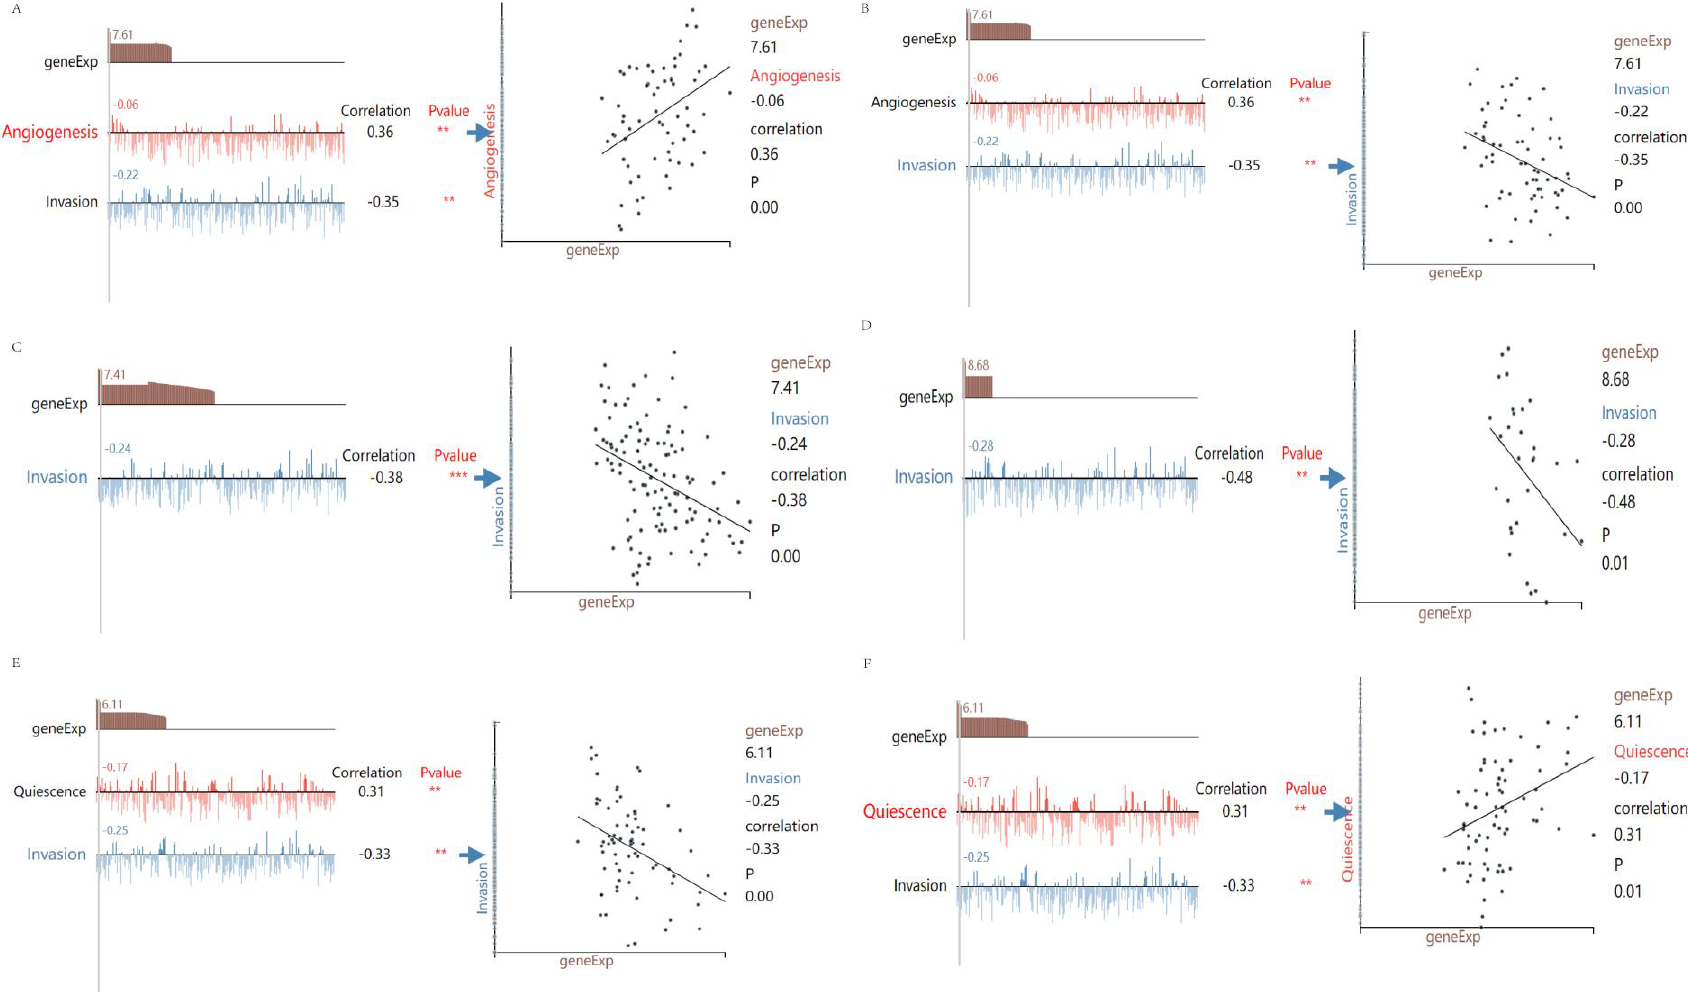
Figure 14. The correlation of the functional states of cancer cells and protein-coding genes at the single-cell level in the CancerSEA database. ( A ) The relationship of CTNNB1 with tumor angiogenesis. ( B – E ) The relationship of CTNNB1 , FOXO3 , MAPK13 , and RAB11A with tumor invasion. ( F ) The relationship of RAB11A with tumor quiescence (** p < 0.01, *** p < 0.001).